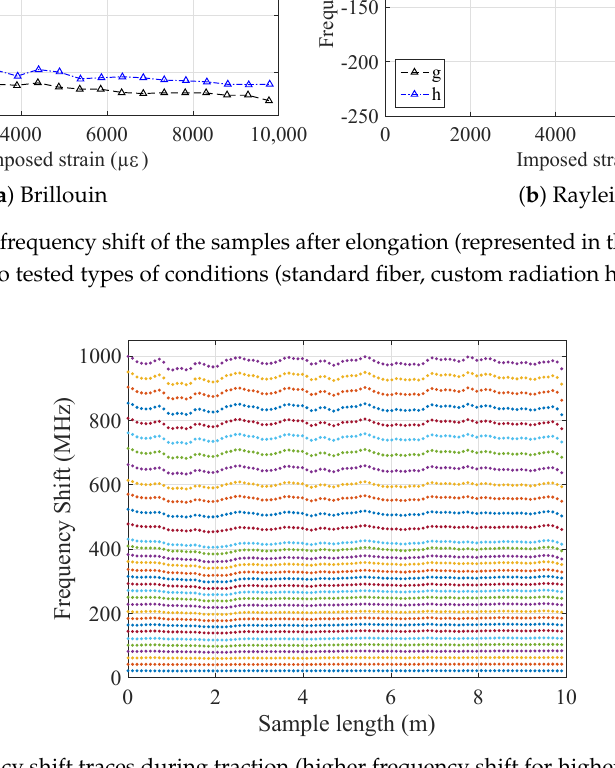
Figure 10. Frequency shift traces during traction (higher frequency shift for higher traction), Sample a, showing no relaxation of the